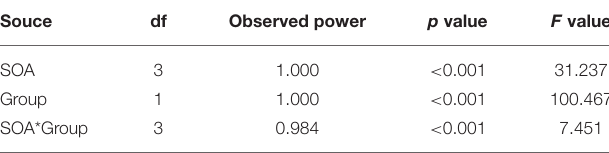
TABLE 3 | Effect of SOA, group and their interaction on amplitude ratio (A2s/A1). Souce df